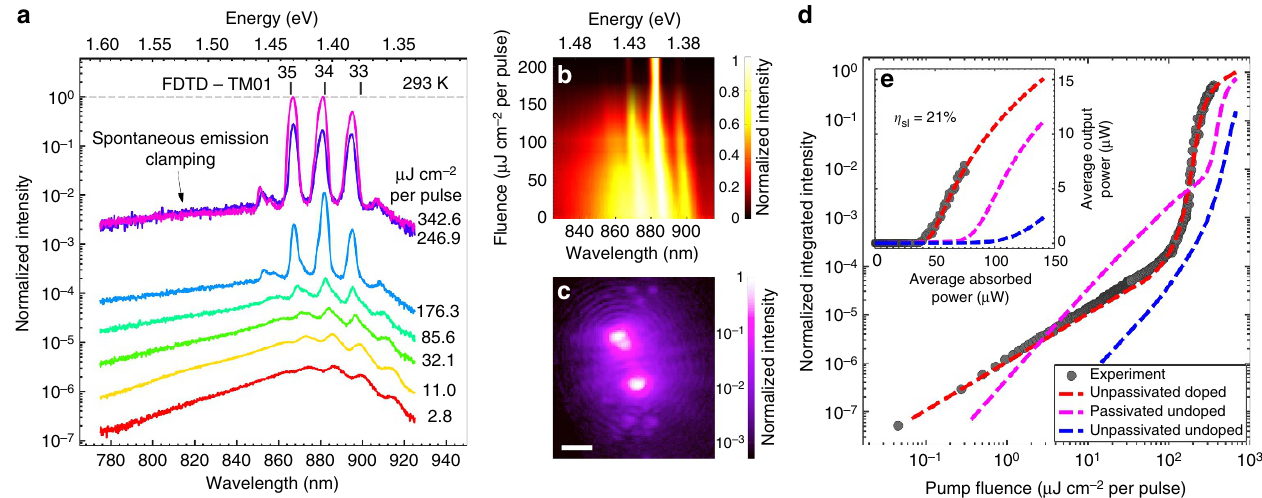
Figure 4 | Room temperature characterization of an unpassivated GaAs NW nanolaser. ( a ) Power-dependant spectra. Note the appearance of ASE from the lowest of pump intensities and the clamping of spontaneous emission at higher pump intensities. The modelled position of several TM01 cavity modes closely match the experimental data. ( b ) Normalized spectral map across pump intensities close to threshold. ( c ) Logarithmic map of a composite optical image showing the lasing NW above threshold. ( d ) Logarithmic plot of integrated intensity of emission as a function of pump power. The clear non-linearity here represents a transition to lasing. Also shown is a fit to the experimental data (dashed red line) and modelling for undoped NWs (dashed blue and pink lines for unpassivated and passivated, respectively). Normalization here is by the highest intensity of the modelled fit. ( e ) Linear scale plot of d revealing slope efficiency, Z sl